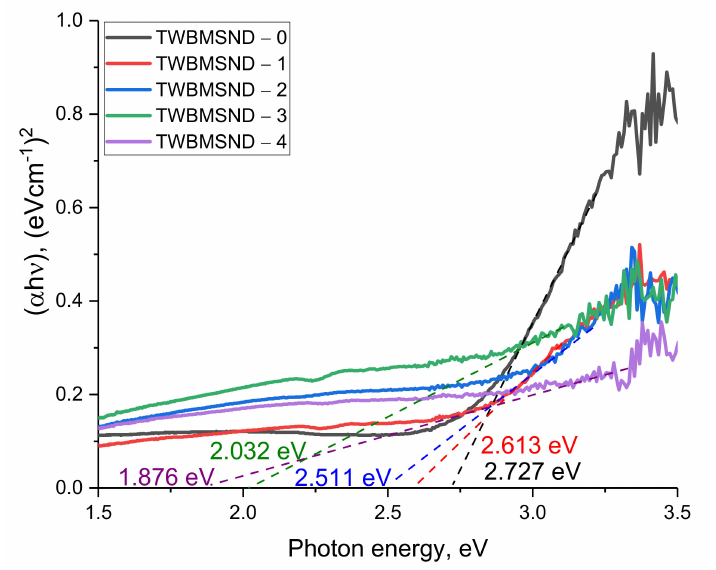
Figure 3. Tauc plot construction results for band gap